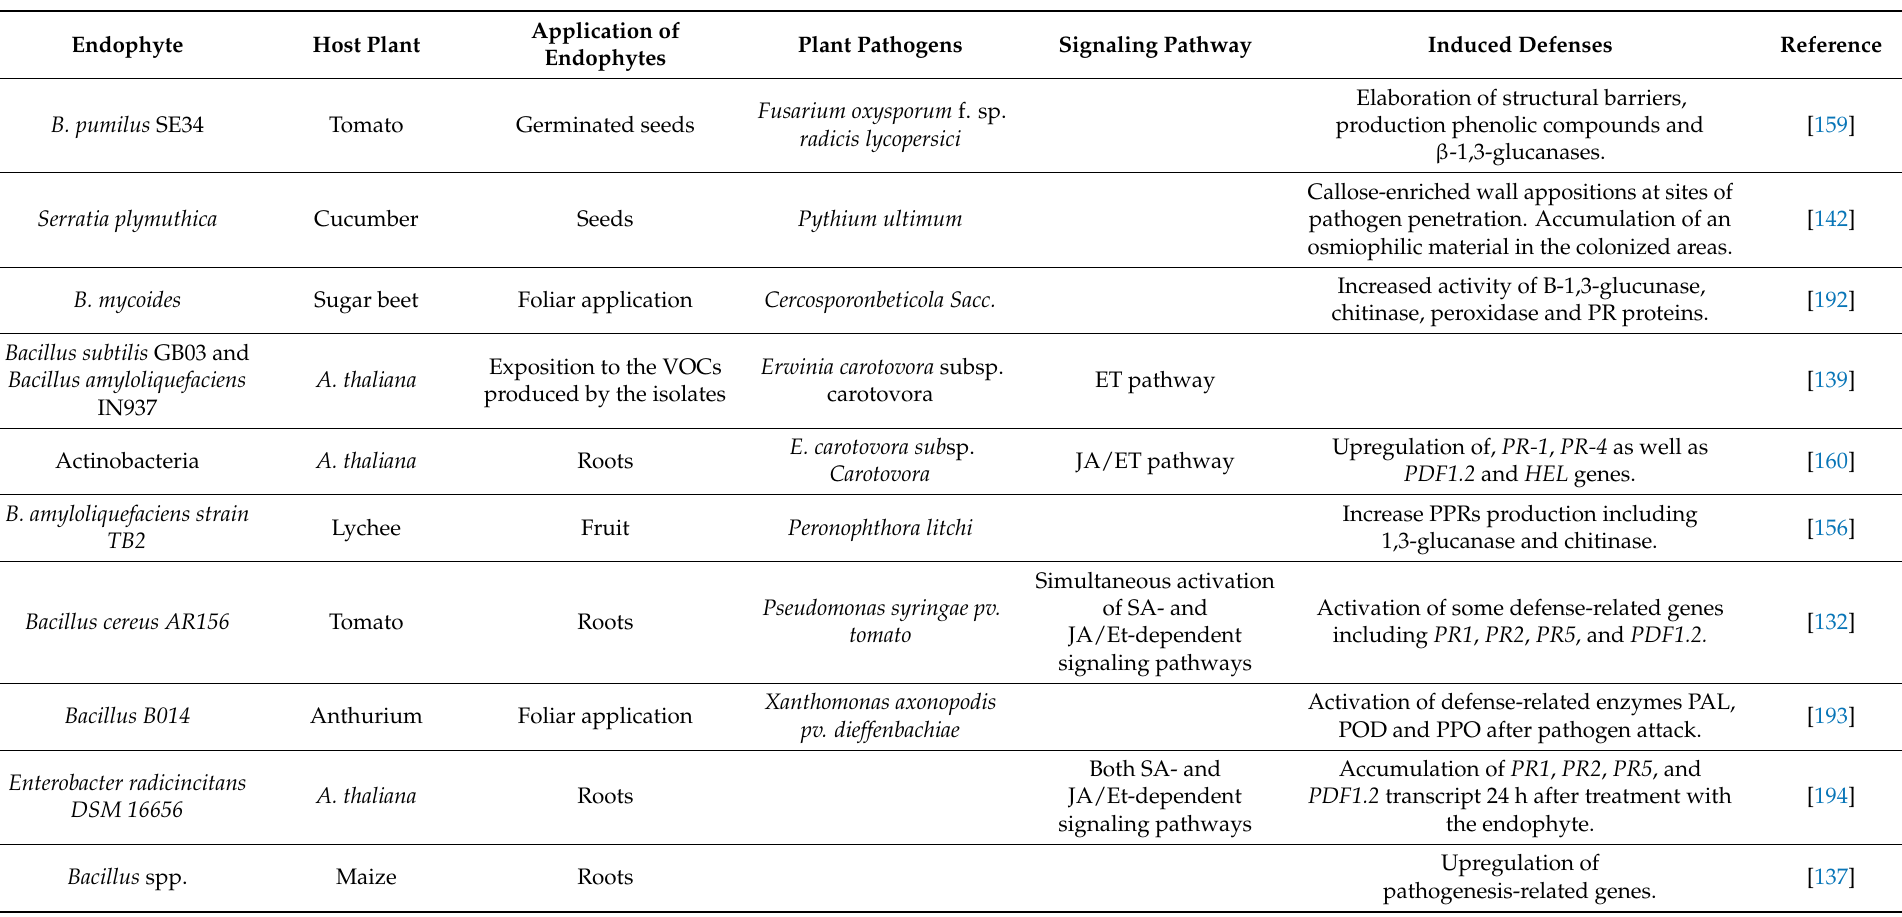
Table 2. Different mechanisms of defenses induced by endophytic